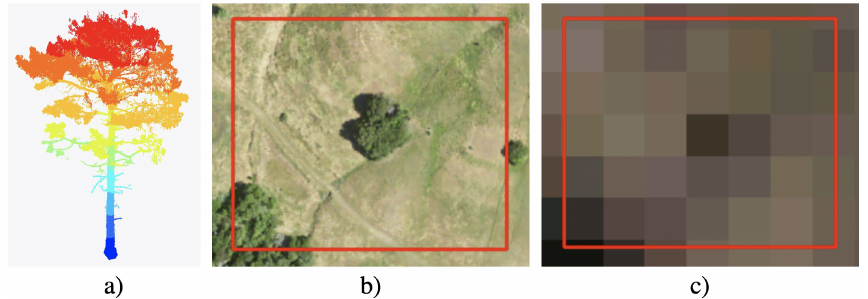
Figure 1. ( a ) Light detection and ranging (LiDAR) scan of a tree; ( b ) 1-meter resolution National Agriculture Imagery Program (NAIP) imagery; ( c ) 30-meter resolution Landsat